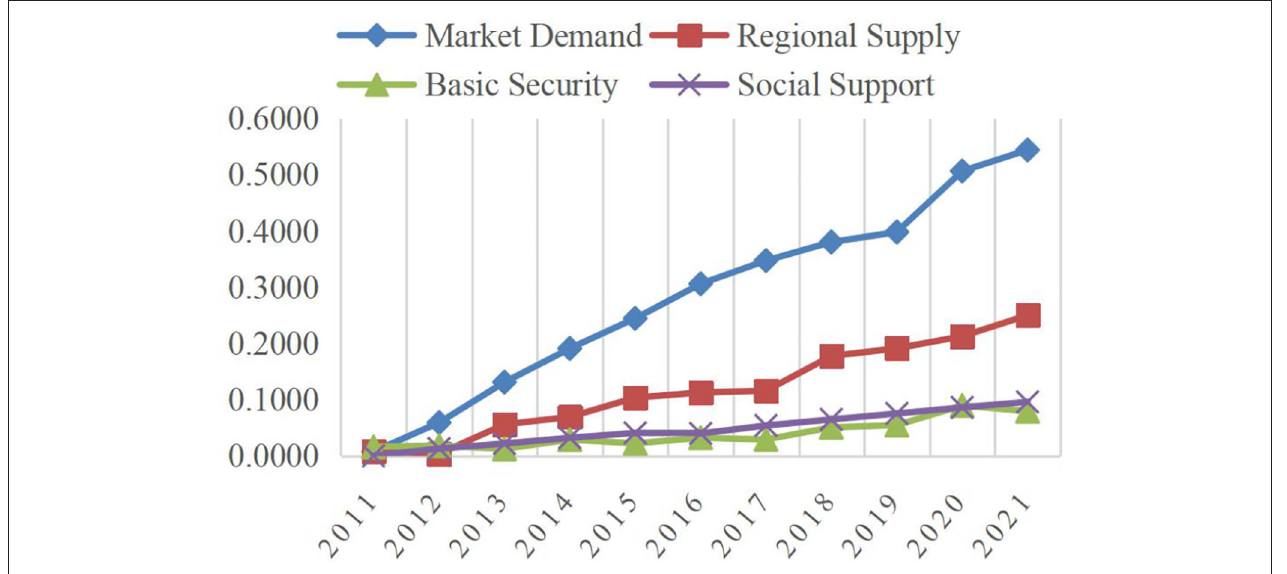
FIGURE 4 | Change in the vertical share of each dimensional index of the tourism economy of Shenzhen,